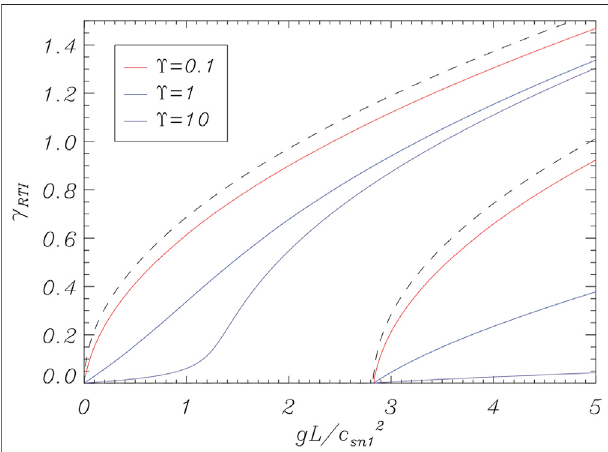
FIGURE 6 | RTi growth rate as a function of the dimensionless gravitationalaccerationobtainedfromthetwo- fl uidlinearanalysisofDíazetal. (2012) in the incompressible case. Two unstable modes are present, with the onerelatedwiththeneutral fl uidbeingpresentinwholerangeandhaving a larger growth rate. The dashed lines correspond to the colisionless limit, while the different solid lines denote different degrees of ion-neutral coupling indicated through the parameter Y (de fi ned in the text). Adapted from Díaz et al. (2012). © AAS. Reproduced with